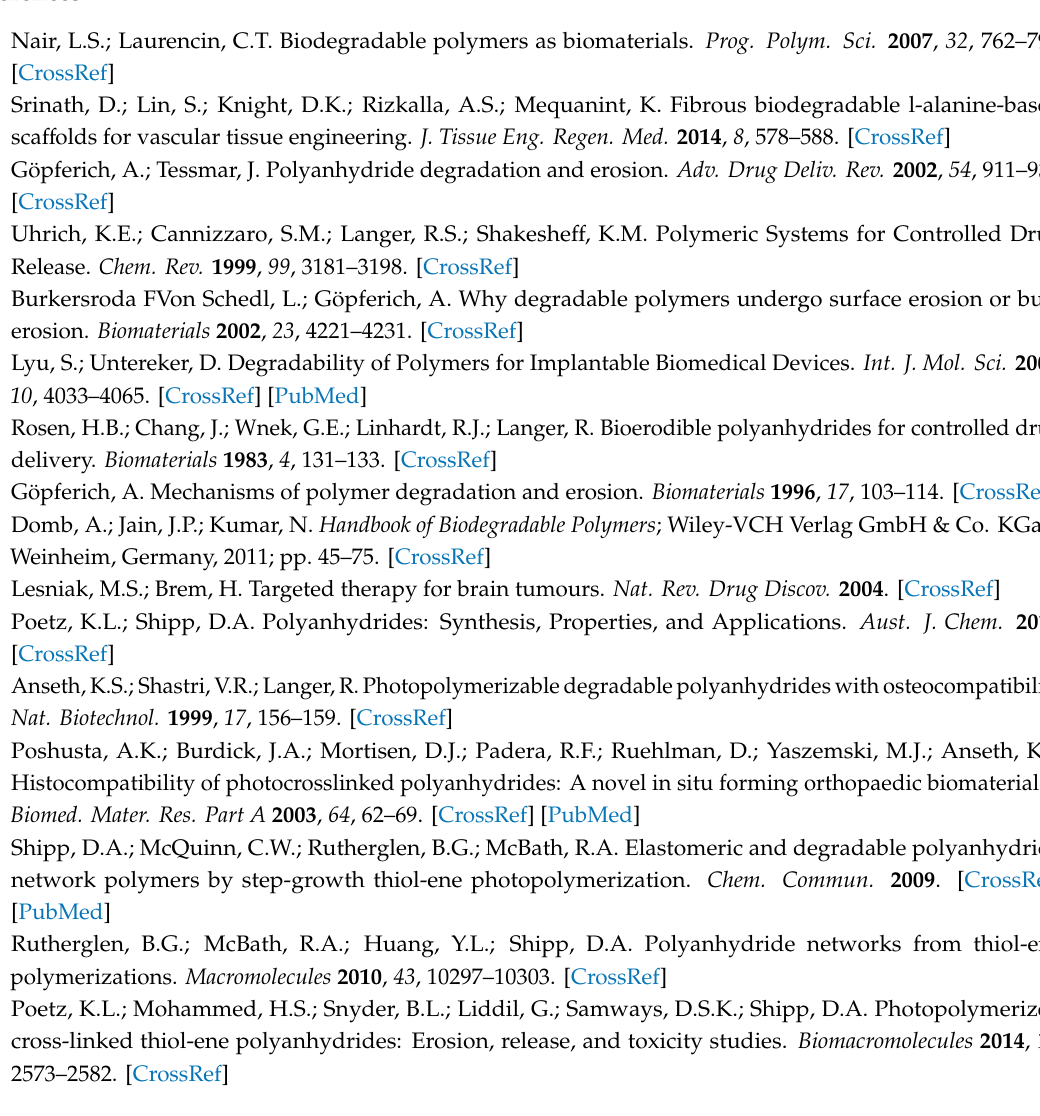
100:75:25. C) 100:50:50. D) 100:25:75. Figure S5: Fitting mass loss data for cylindrical tablets. Linear, quadratic, and cubic fitting curves to the mass loss data of PAHs with initial mole ratios of PETMP:EGDT = 75:25 and 25:75. The R 2 values are shown on the graphs. Figure S6: Fitting mass loss data for cuboid polymers. Linear, and cubic fitting curves to the mass loss data of PAHs with initial mole ratios of PETMP:EGDT = 100:0, 75:25, and 50:50. The R 2 values are shown on the graphs. Figure S7: Cumulative mass eroded as a function of time fitted to zero-order kinetic model for cylindrical and cuboid PAH tablets. Figure S8: Log of the remaining mass as a function of time fitted to first-order kinetic model for cylindrical and cuboid PAH tablets. Figure S9: Fractional mass eroded percentage as a function of square root of time fitted to Higuchi kinetic model for cylindrical and cuboid PAH tablets. Figure S10: Log of the fractional mass eroded percentage as a function of the log(time) fitted to Korsmeyer-Peppas kinetic model for cylindrical and cuboid PAH tablets. Figure S11: Cubic root of fractional mass eroded as a function of time for cylindrical (A-C) and cuboids (D-F) PAH tablets with di ff erent crosslinking ratios in PNA: PETMP:EGDT systems. Fitted kinetic models with red dots (experimental data) and green lines are the fitted curves for Hixson-Crowell (A-C) and Hopfenberg (D-F) release kinetic